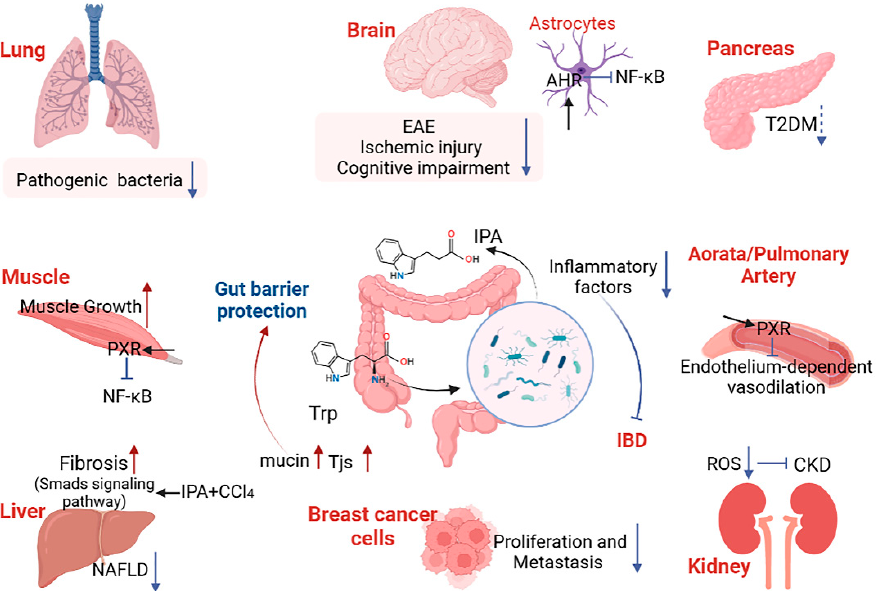
Figure 3. Summary of IPA production and functions. Red upward arrows indicate promotion, and blue downward arrows indicate inhibition. The dashed line indicates that further experimental verification is required. IPA: indole propionic acid, Trp: tryptophan, EAE: experimental autoim-